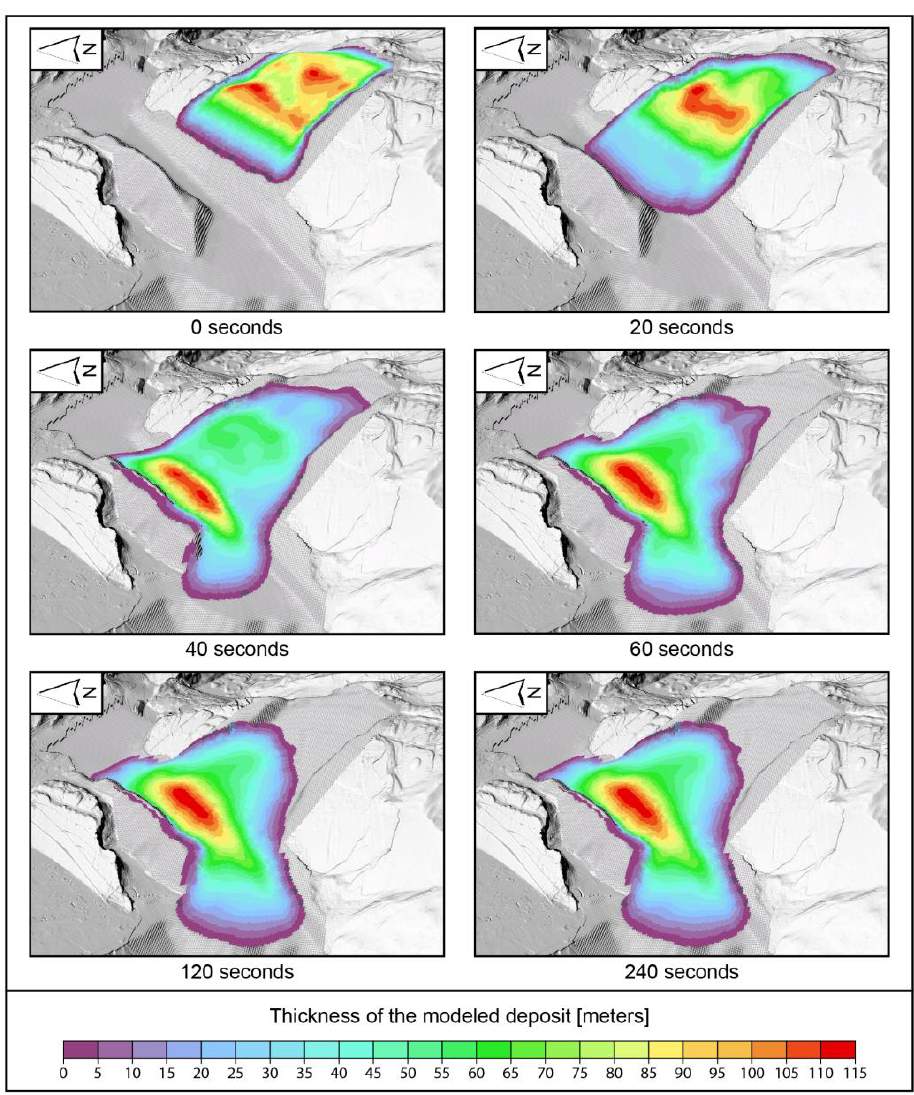
Figure 9. 3D overview of Dan3D-Flex modeling results for runout distance and thickness over time (for details, see text). The rock avalanche impacts and is deflected by the Santa Lucia ridge. For reference, the approximate length of this ridge is 1 km.